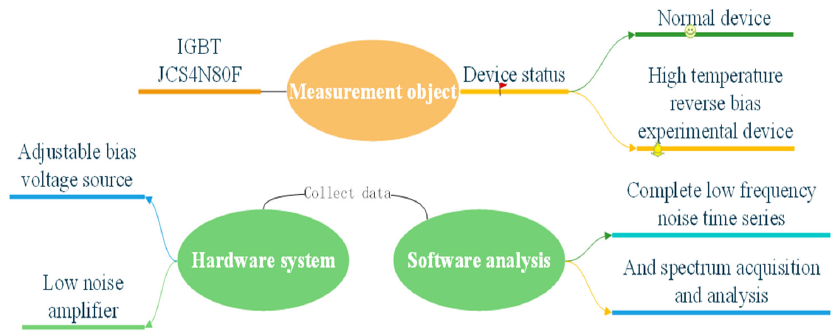
Figure 3. IGBT low-frequency noise detection scheme.